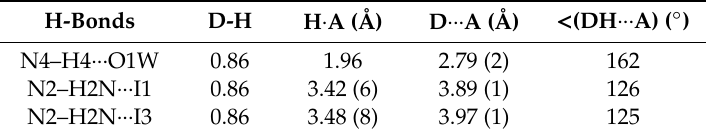
Figure 1. The asymmetric unit of Bi 4 I 16 · 4(C 6 H 9 N 2 ) · 2(H 2 O), showing the atomic numbering scheme. Table 3. Hydrogen bonds in Bi 4 I 16 · 4(C 6 H 9 N 2 ) 2(H 2